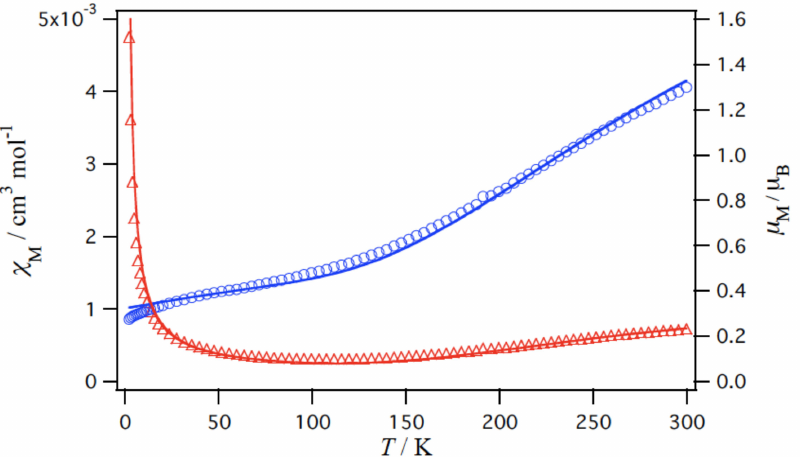
Figure 3. Temperature dependence of magnetic susceptibility χ M ( ∆ ) and magnetic moment µ eff ( ◦ ) of [Cu 2 ( L 1 ) 2 ] ( 1